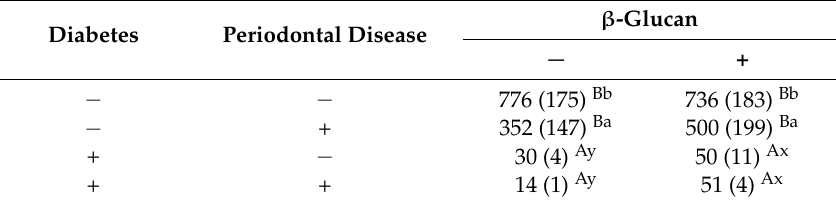
A,B Different letters in the columns indicate a significant difference between the groups with and without diabetes ( p < 0.05); a,b Different letters in the columns indicate a significant difference between the groups with and without periodontal disease ( p < 0.05); x,y Different letters in the rows indicate a significant difference between the groups with and without β -glucan ( p < 0.05).